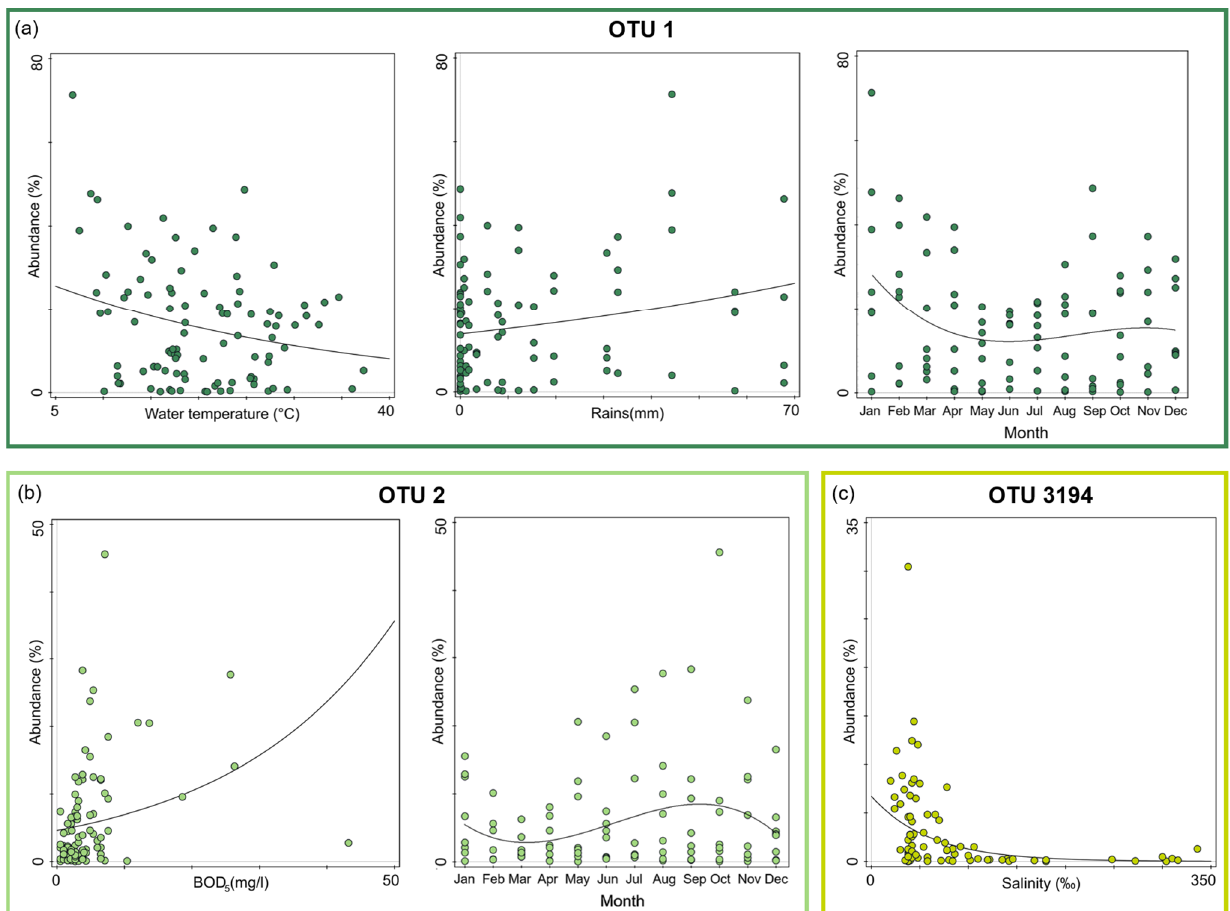
Figure 7. GLM plots showing the significant trends of the most abundant OTUs in relation to the environmental parameters along the ST salinity gradient. OTU 1 abundance variation according to the water temperature, the rain, and the sampling month ( a ); OTU 2 abundance variation according to the BOD 5 and the sampling month ( b ); OTU 3194 abundance variation according to the salinity ( c ).